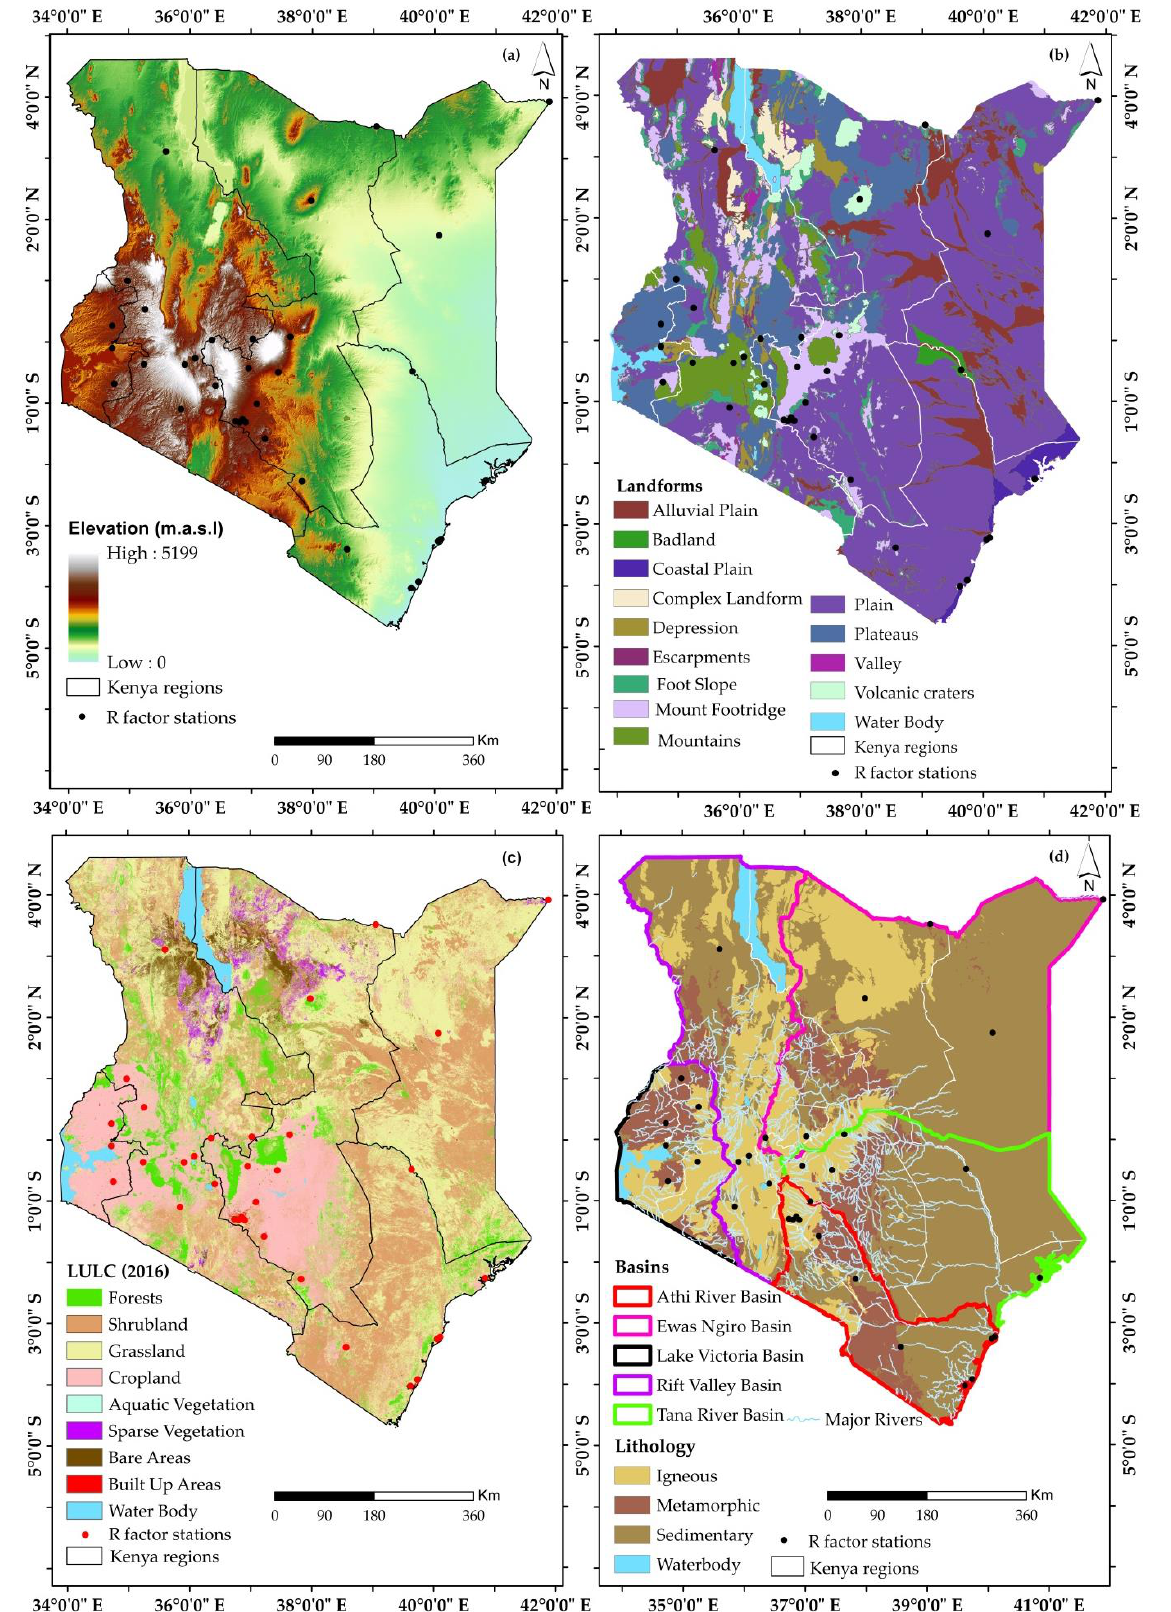
Figure 3. Characteristics maps of the study area: ( a ) Elevation; ( b ) Landform types; ( c ) Land use and land cover, 2016; ( d ) Major river basins in Kenya.